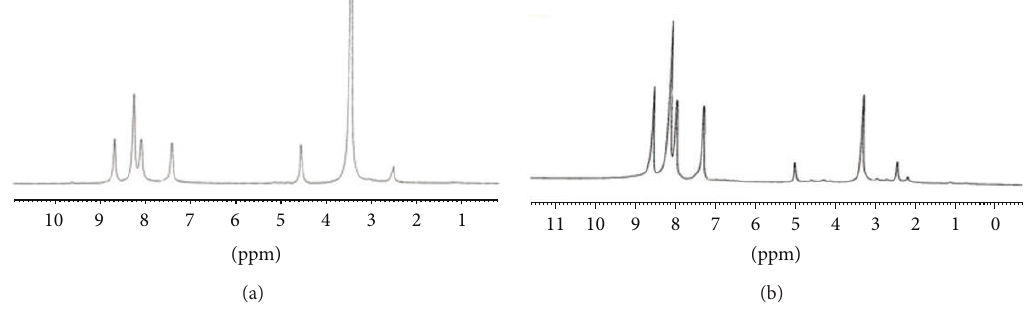
Figure 4: 1 H-NMR spectra of (a) BEF ligand and (b) BEF–Zn.